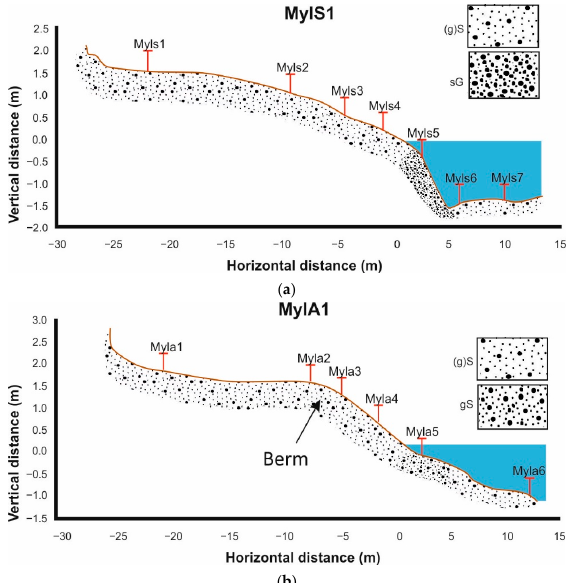
sorted (Figure 14a,b).